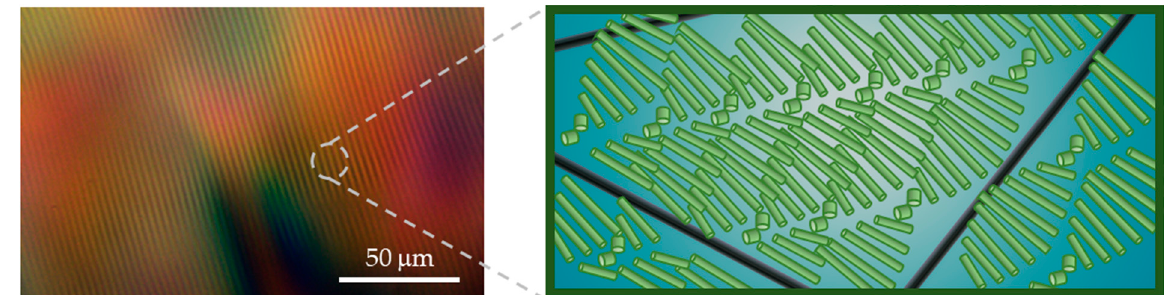
Figure 7. CNCs–1% F108–SWNTCH. POM image ( left ) and schematic illustration (not to scale) of the two co-existing networks ( right ): chiral mesostructure of CNCs (light green) and percolated SWNT network (black). The surfactants decorating the nanostructures and their assemblies in solution are not shown in the sketch.